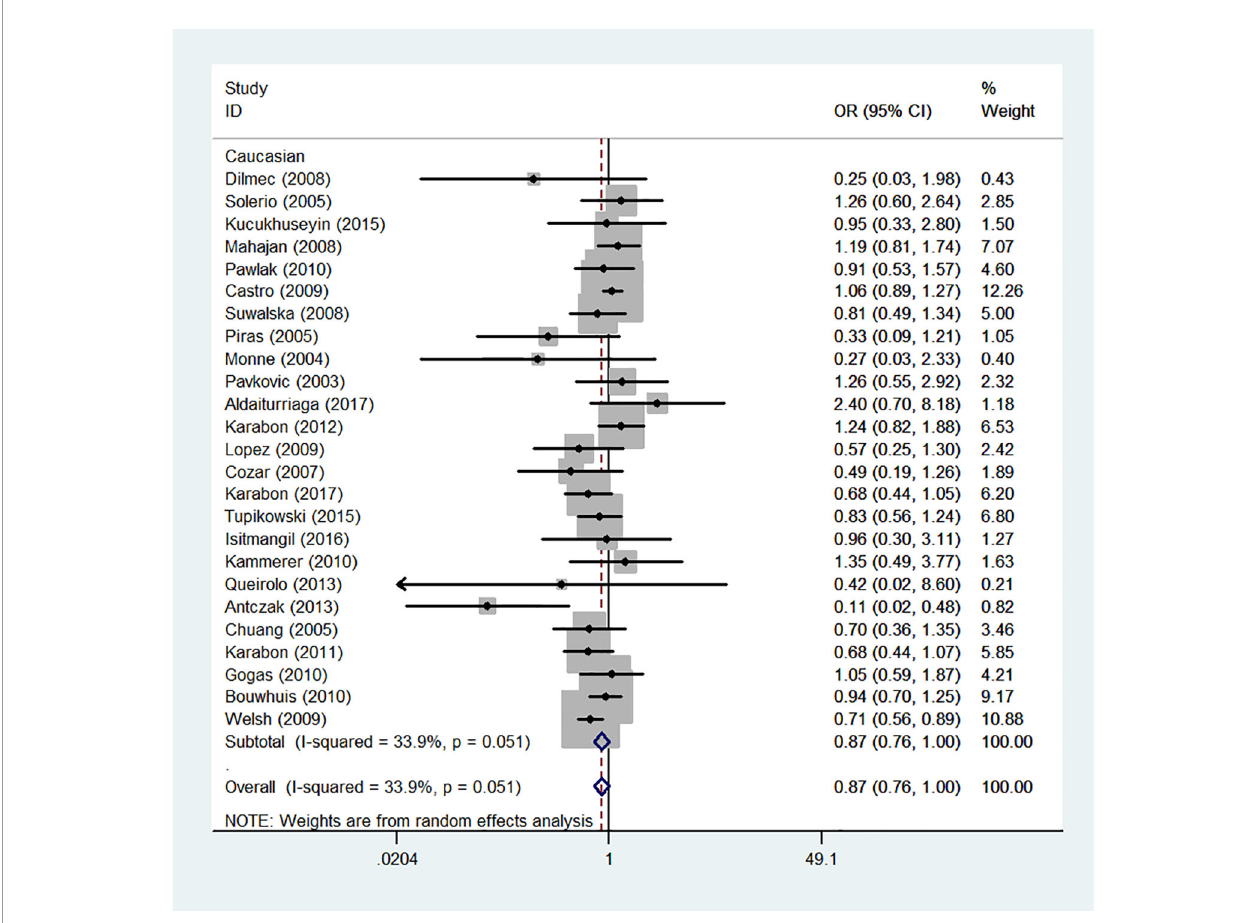
FIGURE 10 | Forest plot of cancer risk associated with the CTLA-4 gene rs231775 polymorphism in Caucasians (G-allele vs. A-allele